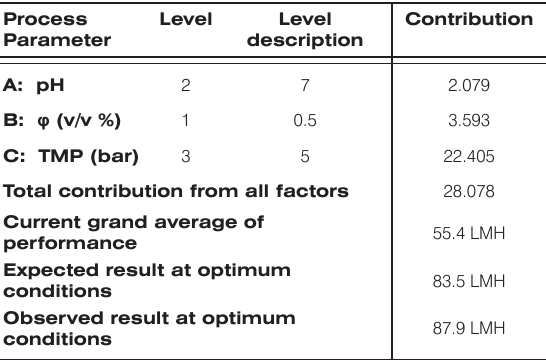
Table 7. Optimum conditions given by